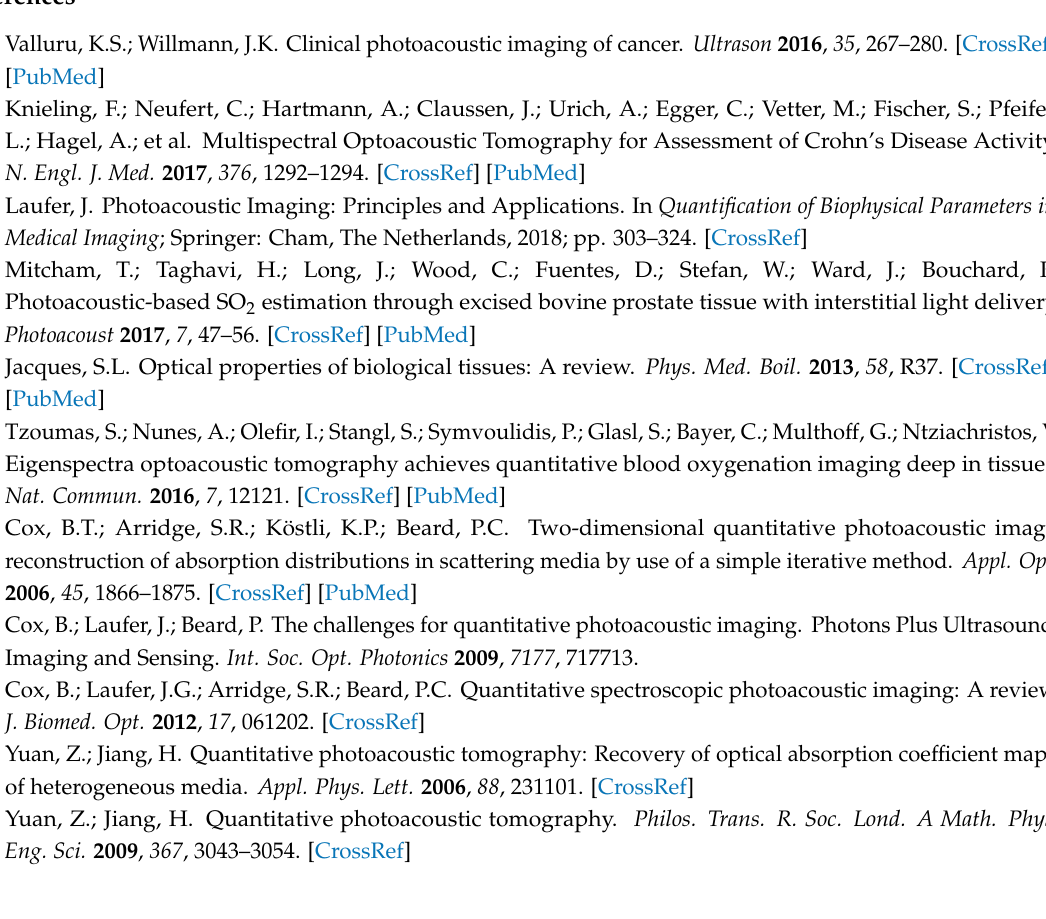
Figure A4. Sample images showing the best, the worst, and the median performance of our method when considering only the 50% most confident quantification estimations. All images show the ( a ) ground truth absorption coefficients ( b ) reconstructed absorption, ( c ) error estimate from external model, ( d ) the actual quantification